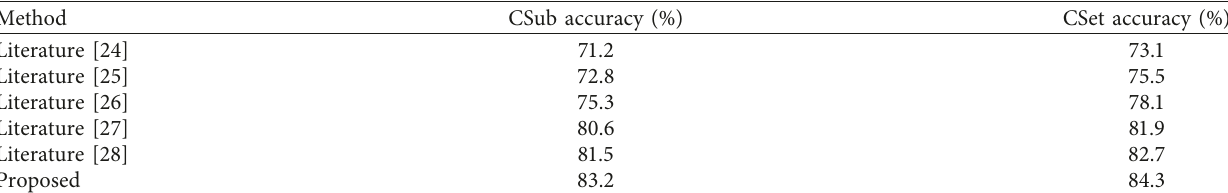
Table 4: Performance comparison of NTU-RGB+D 120 data